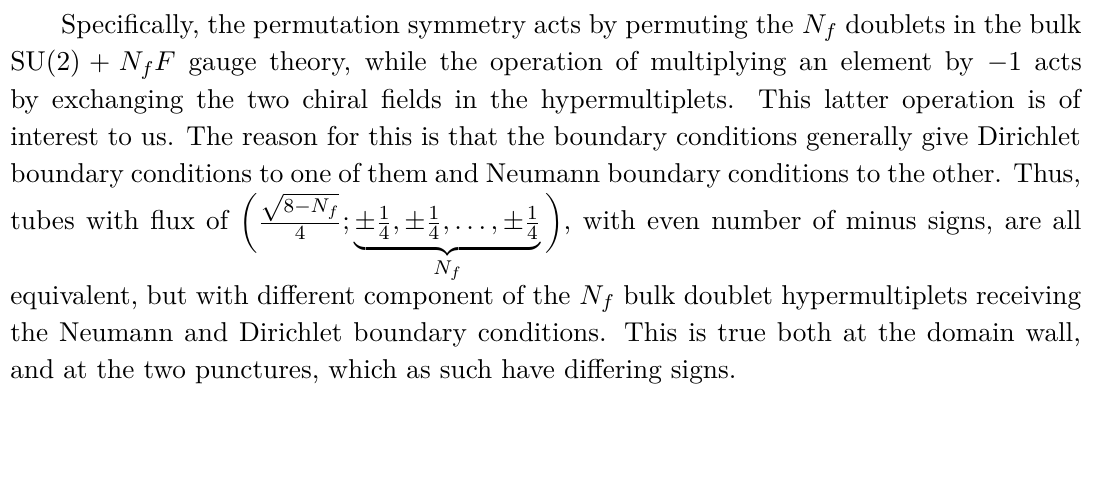
Figure 1 . The conjectured 3 d theory associated with the compactification of the rank 1 5 d E N SCFT on a tube with two maximal punctures and flux squares denote SU type global symmetries, and lines connecting them denote bifundamental chiral fields under the connected groups. We also use crosses over fields to denote flipping, that is that there is an additional chiral field linearly coupled to the invariant made from the field being flipped under the non-abelian global symmetries. Finally, W denotes the superpotentials, with the last term being the flipping